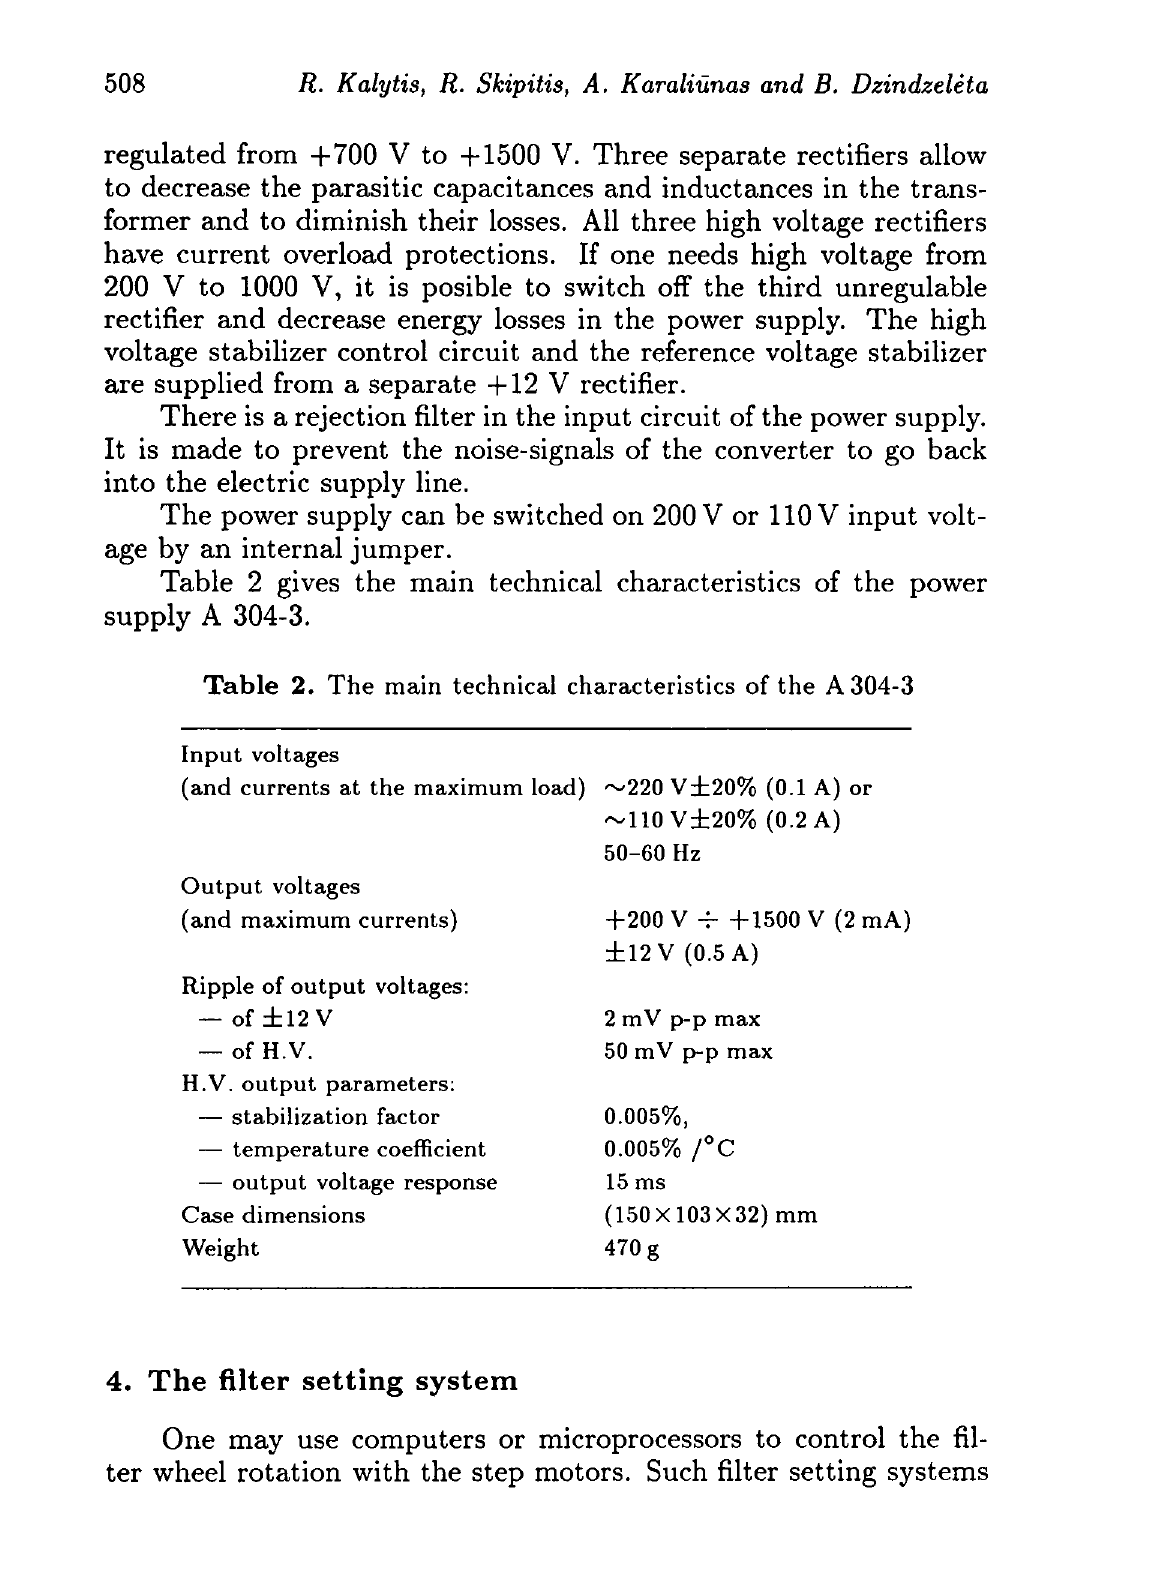
Table 2. The main technical characteristics of the A 304-3 Input